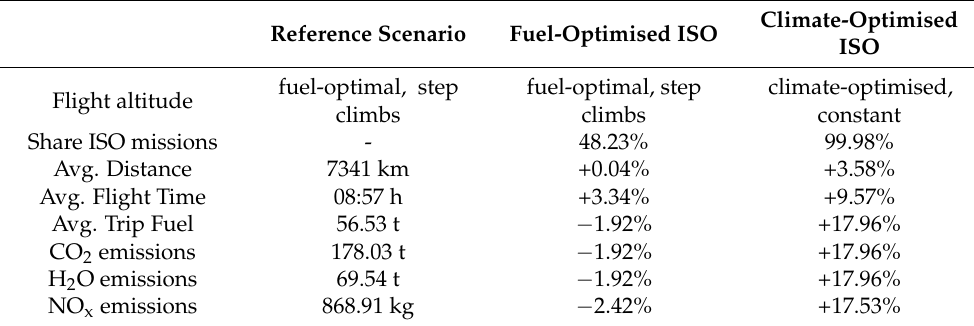
Table 1. Comparison of key parameters of an average flight of the underlying sample in reference case, fuel-optimised ISO and climate-optimised ISO.